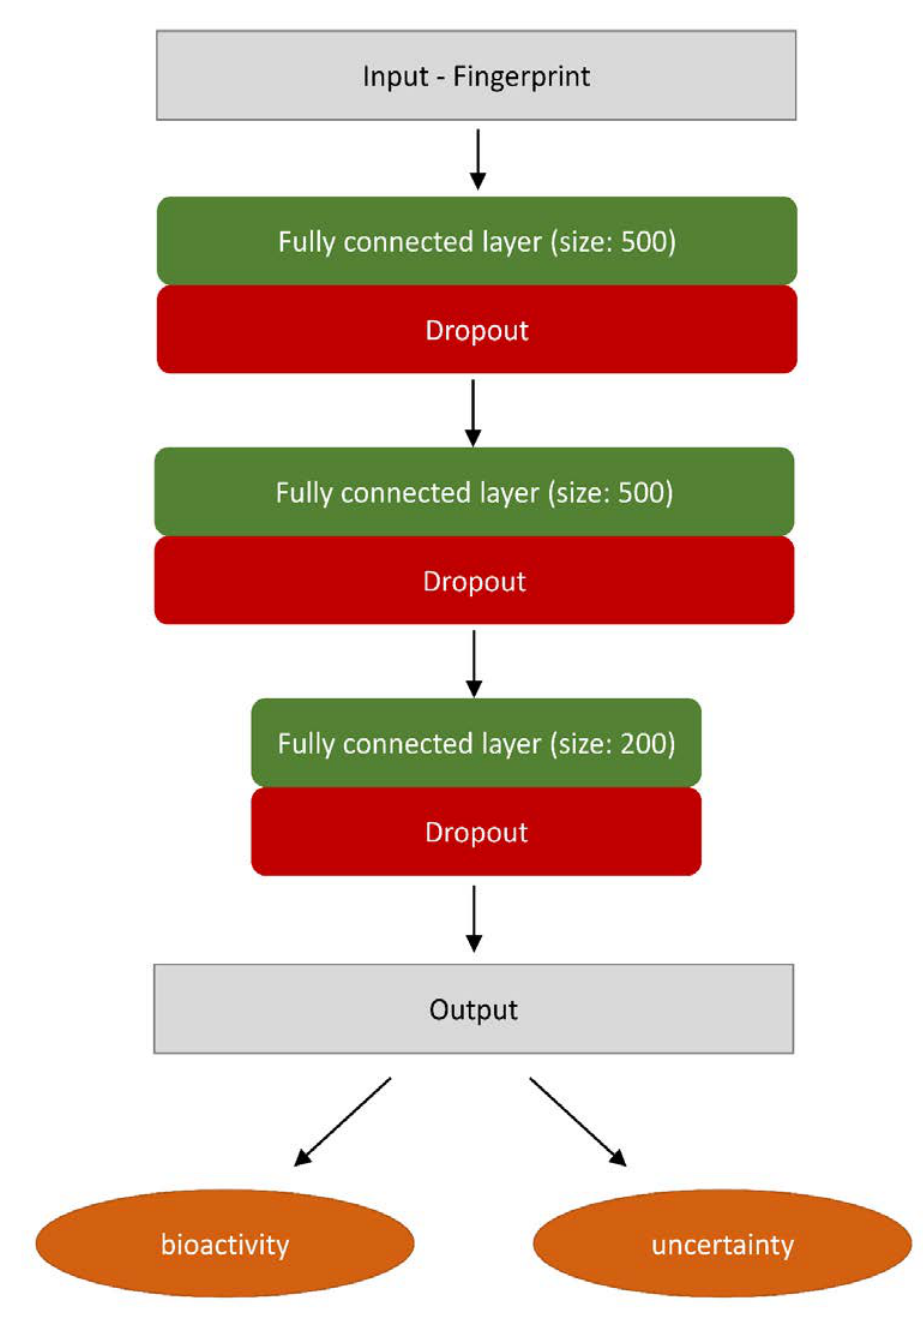
Scheme 1. Neural network used in the study.